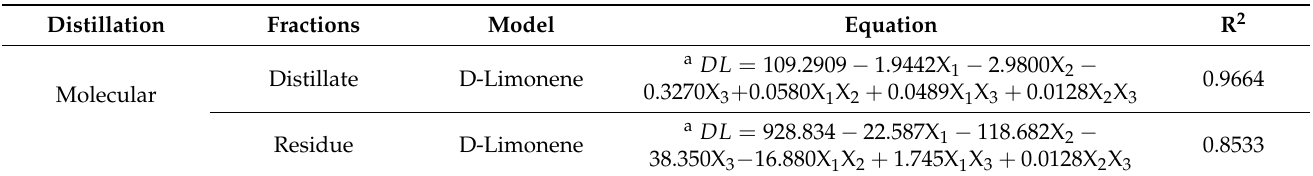
Table 5. Predictive models in molecular distillation (distillate and residue) for D-Limonene and its correlation coefficient.